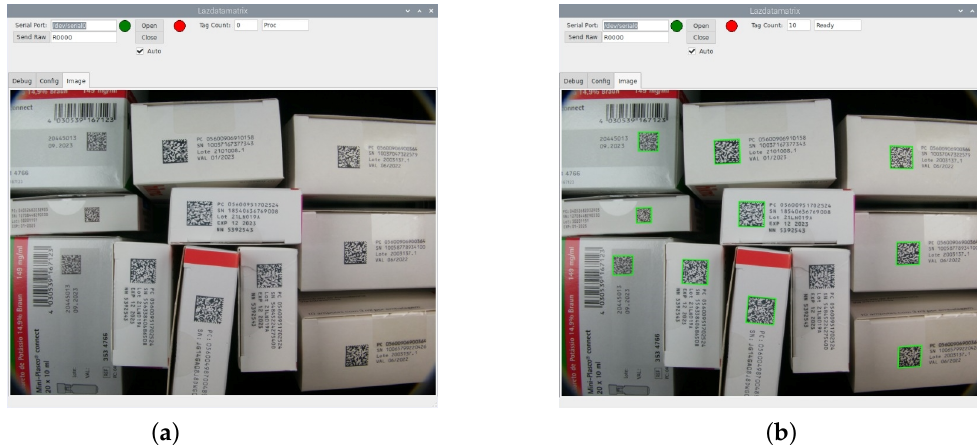
Figure 11. Medicine packages: ( a ) to be scanned; and ( b ) torn code paper is not detected by the